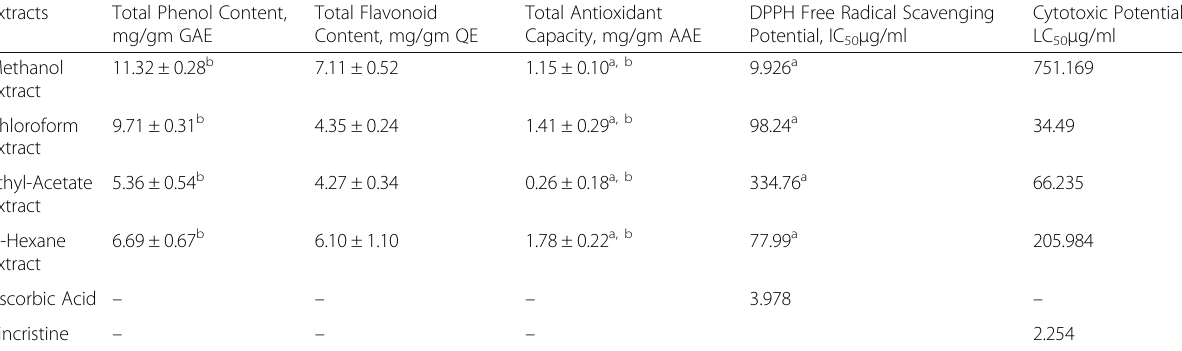
Table 2 Antioxidant and cytotoxic potential of different extracts of Cheilanthes tenuifolia Extracts